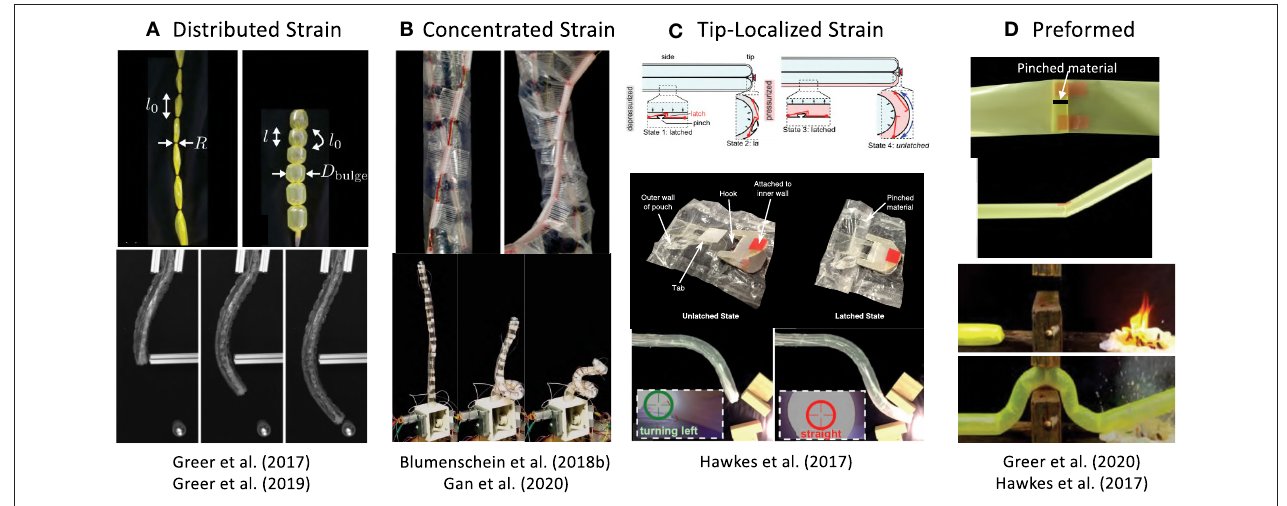
FIGURE 3 | Methods of actuating everting vine robot growth direction and shape, including (top) actuation principles and (bottom) examples of implementation. (A) Distributed strain uses pneumatic artificial muscles to create strain along the length where they are attached. (B) Concentrated strain uses tendons actuated from the base to change the robot shape. (C) Tip-localized strain couples steering and growth to create responsive steering at the tip only. (D) Preformed steering shapes the robot for known tasks before deployment. Modified from Greer et al. (2019). The publisher for this copyrighted material is Mary Ann Liebert, Inc. publishers. Modified from Greer et al. (2017) © IEEE 2017, Blumenschein et al. (2018b) © IEEE 2018, and Gan et al. (2020) © IEEE 2020. Modified from Hawkes et al. (2017). Reprinted with permission from AAAS. Modified from Greer et al.